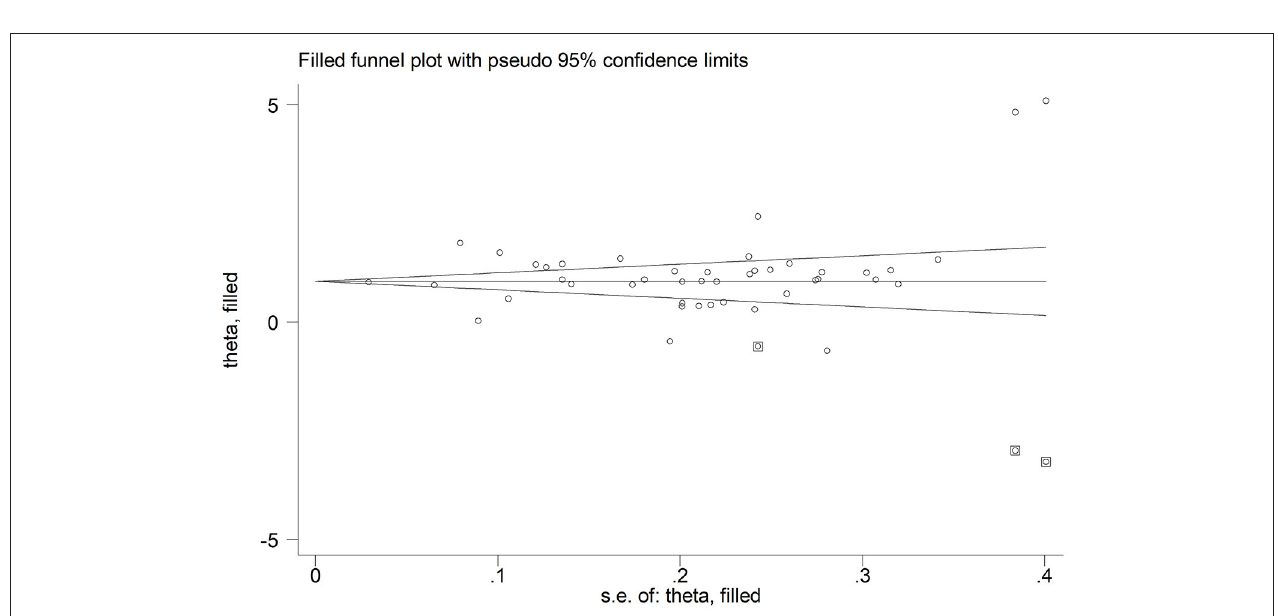
FIGURE 4 | Funnel plot of studies investigating disease severity or survival status after trimming and filling. Enclosed and free circles indicate dummy and genuine studies, respectively.